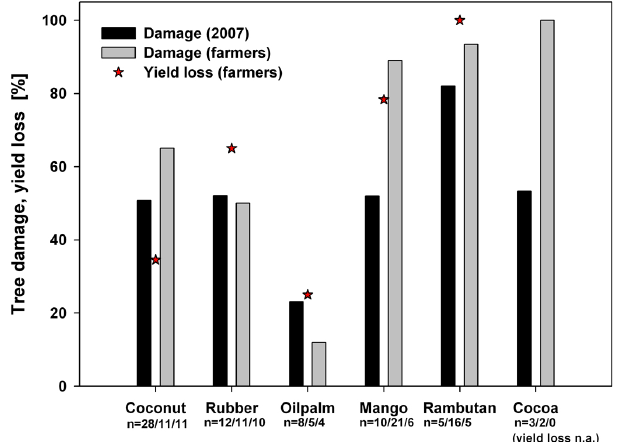
Fig. 6. Tree damage and yield loss in 2005 as reported by farmers and tree damage according to inventories during this study in 2007. Numbers of observations refer to cases of damage as observed in 2007, and damage and yield loss 2005 reported in retrospective by